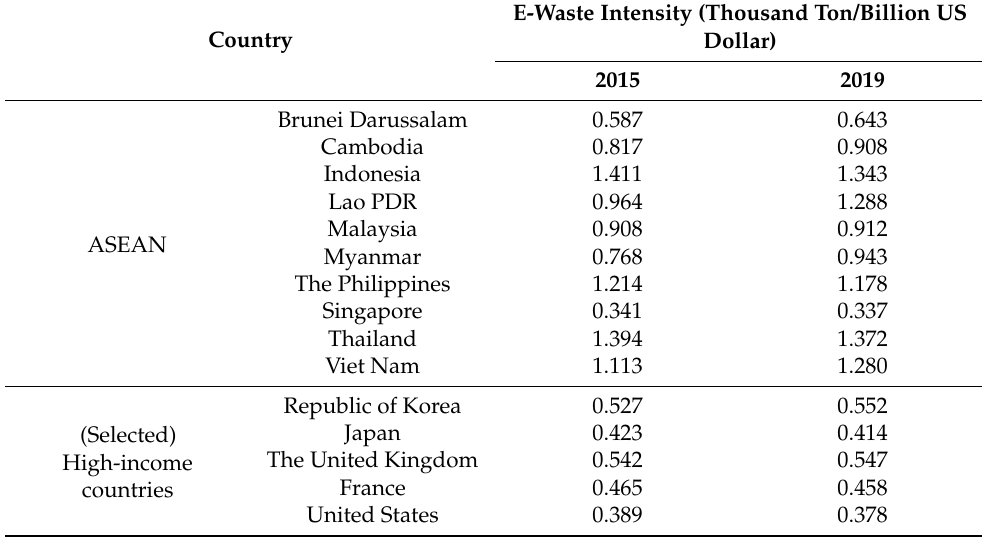
Table 4. E-waste intensity comparison among ASEAN and selected high-income countries. E-Waste Intensity (Thousand Ton/Billion Country